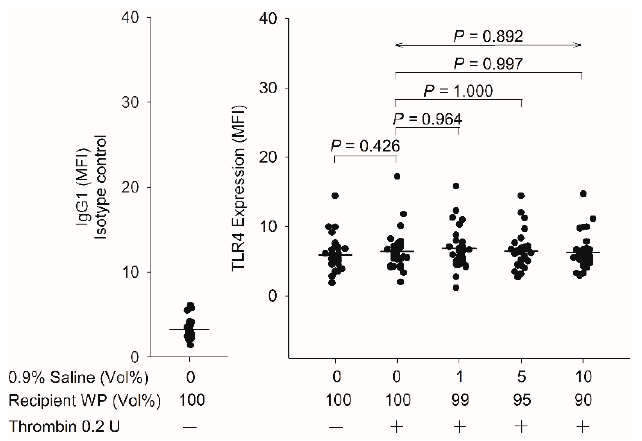
Figure 1. Effect of TLR4 expression after 0.9% saline was mixed with washed platelets (group M, n = 10; group S, n = 10; and group I, n = 11). WP, washed platelets; vol, volume; MFI, mean fluorescence intensity. Data are presented as mean ± SD.